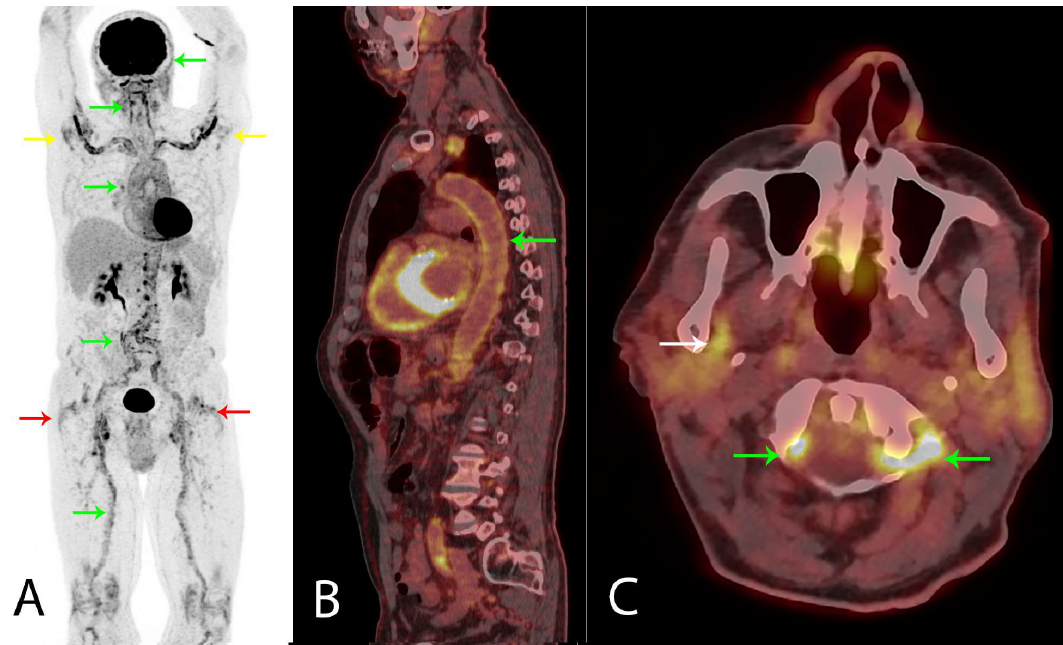
Figure 1. A healthy 80-year old man had, during the last six month period, experienced a 5 kg non-intended weight loss, malaise, coughing, and extreme fatigue. Before the symptoms started, he was physically active and bicycled 20–40 km and rowed 10–15 km per week. As symptoms progressed, muscle tenderness in the shoulder and hip regions made exercising impossible. No morning stiffness of the joints was experienced. Blood tests showed a mild normocytic normochromic anemia, elevated C-reactive protein (100 mg/L), and erythrocyte sedimentation rate (88 mm/h). PMR was suspected, but malignancy was a differential diagnosis. A total of 3.85 MBq/kg 18 F-FDG was administrated an hour before a whole body PET/CT scan was performed. ( A ) Frontal PET MIP showed highly increased 18 F-FDG uptake diffusely around shoulder (yellow arrows) and hip joints (red arrows), indicating bursitis, but also in the wall of the large arteries (green arrows), indicating synchronic LVV confirmed on ( B ) sagittal fused PET/CT of the aorta (green arrow). The LVV aorta and its major branches are affected, but the vertebral (green arrows) and maxillary (white arrow, right side shown) arteries could also be involved, ( C ) axial fused PET/CT. Notably, the 18 F-FDG uptake in the affected arteries (not quantitatively shown) was more than two times the uptake in the liver, which has been shown to accurately indicate LVV on PET/CT